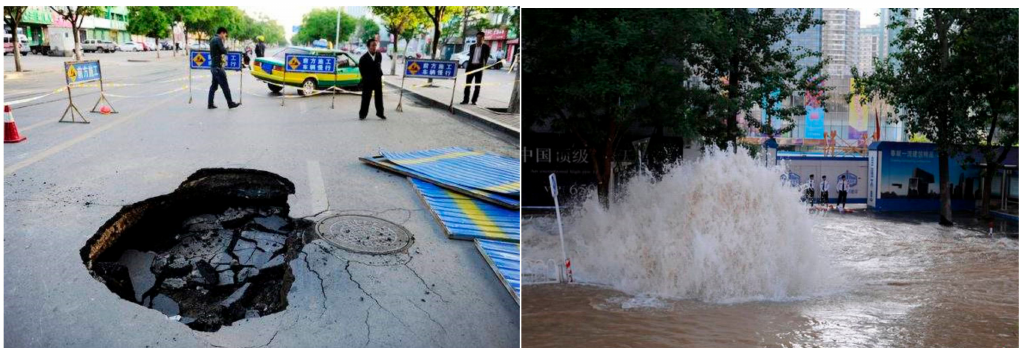
Figure 1. Pavement collapse and pipe burst caused by cracks in concrete